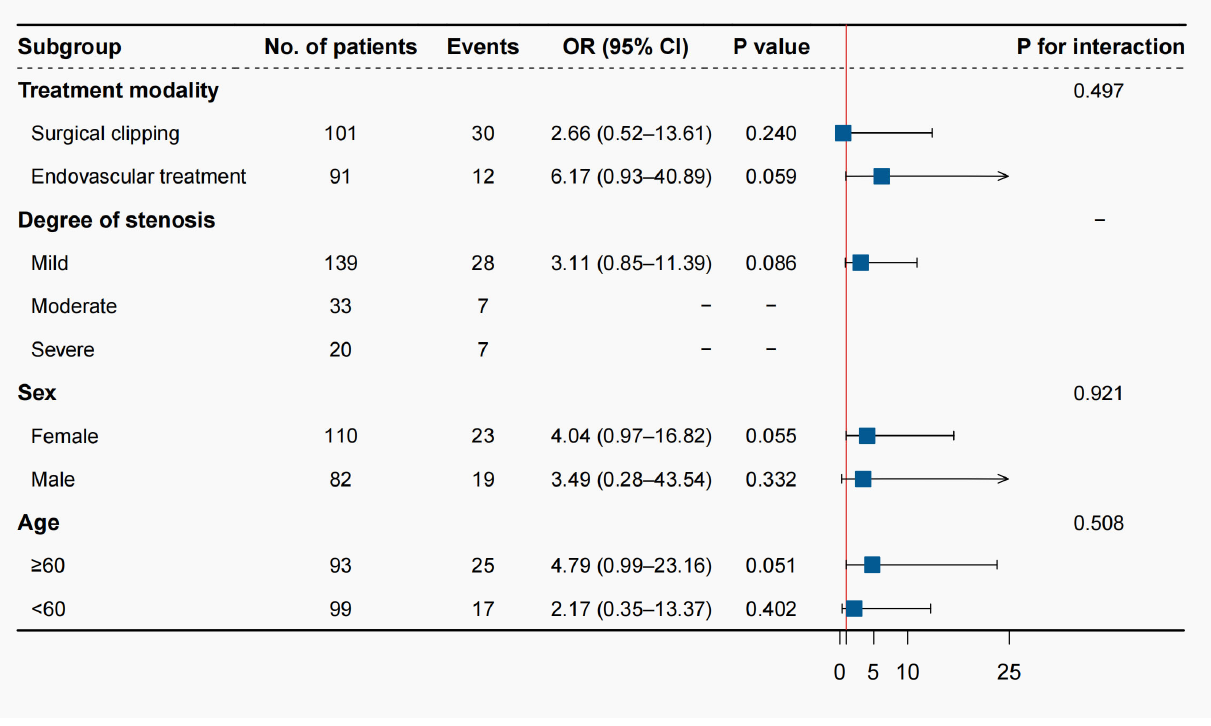
Figure 2. Prespecified subgroup analysis.